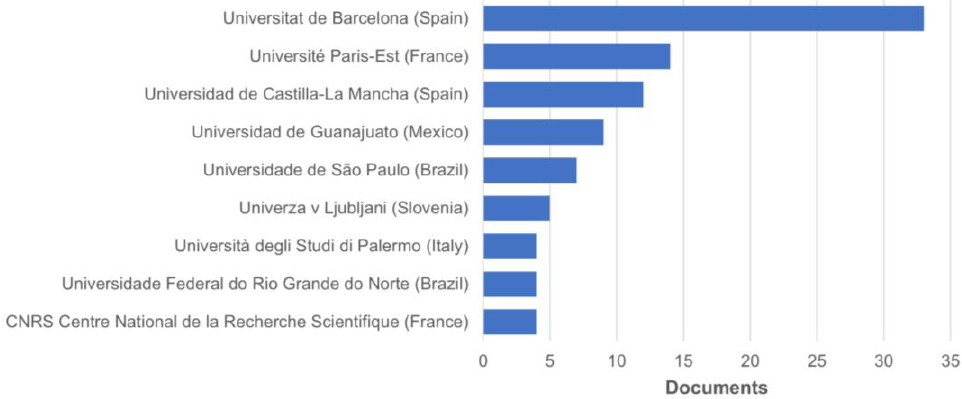
Figure 8. Number of publications per university and research center with more than four publica- tions on EAOPs using diamond technology for water treatment, based on the SLR article selection performed in the Scopus database. Considered period: 2002 – 2022. Source: the authors.